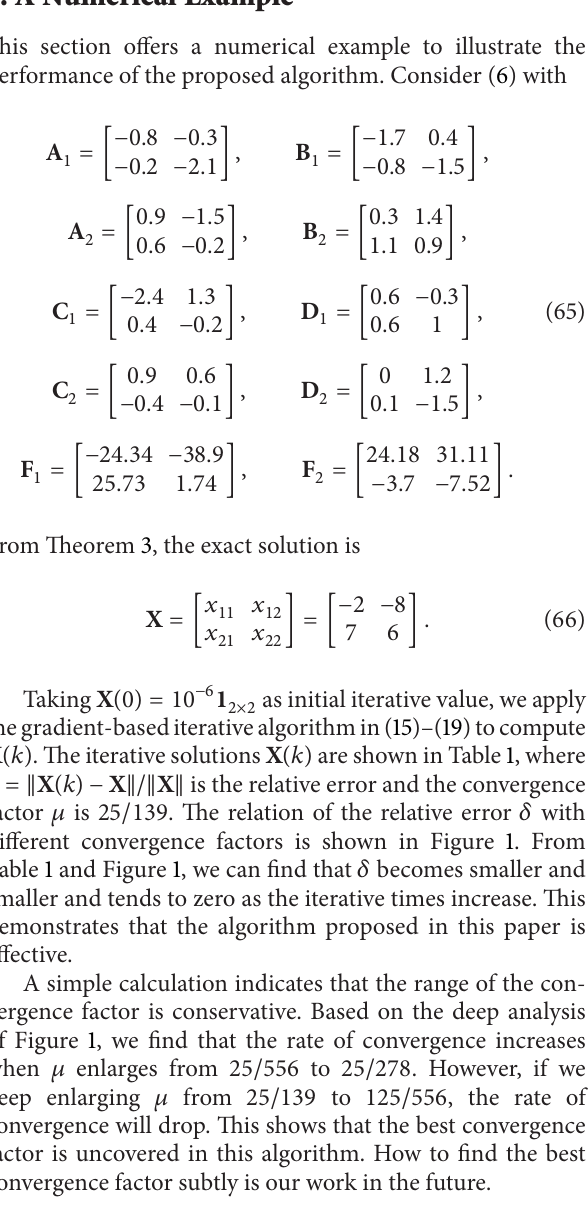
Table 1: The gradient iterative solution ( 𝜇 = 25/139